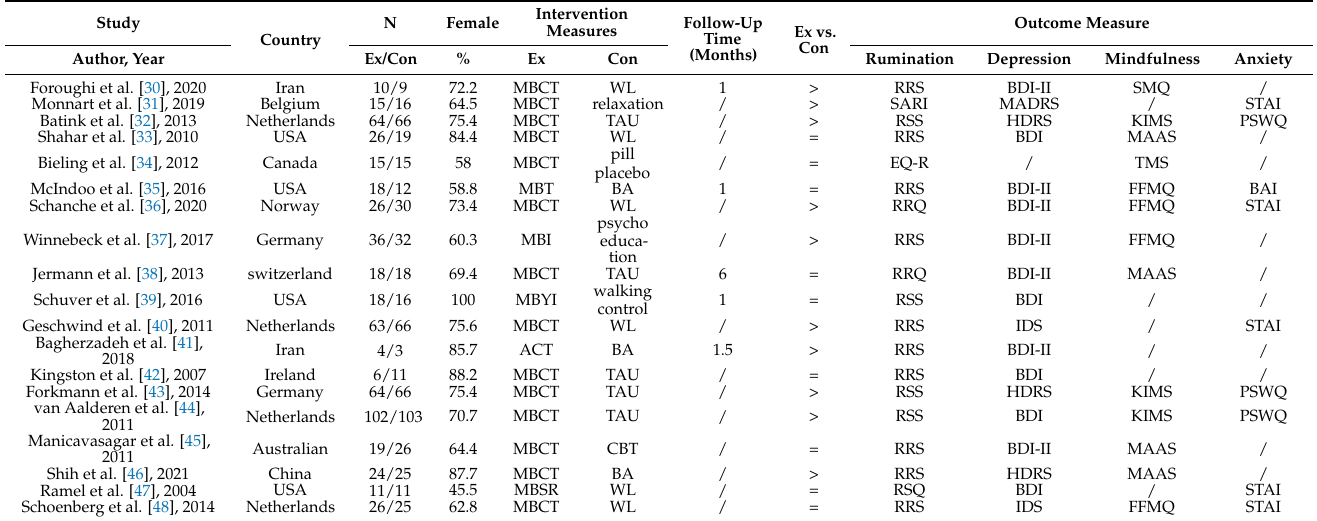
Table 1. Characteristics of the nineteen studies